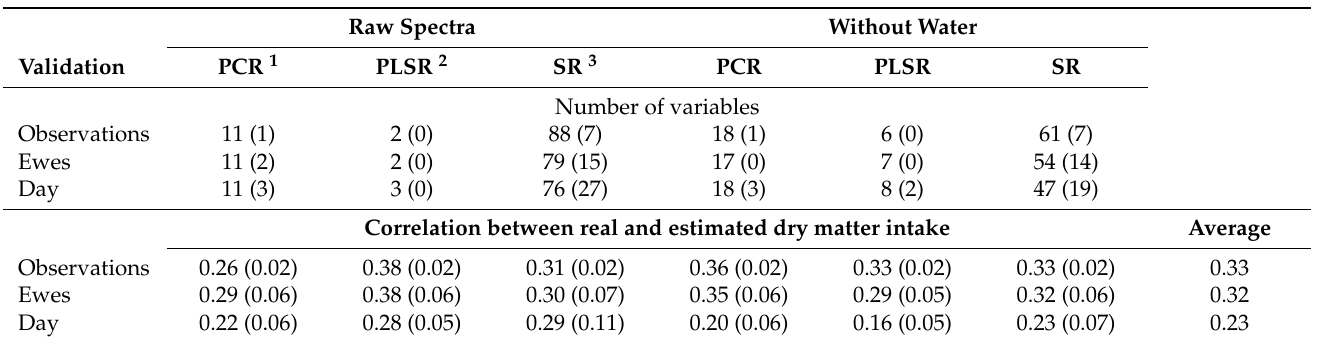
Table 3. Results of the dry matter intake prediction and average correlations (standard errors) between real and estimated dry matter intake.